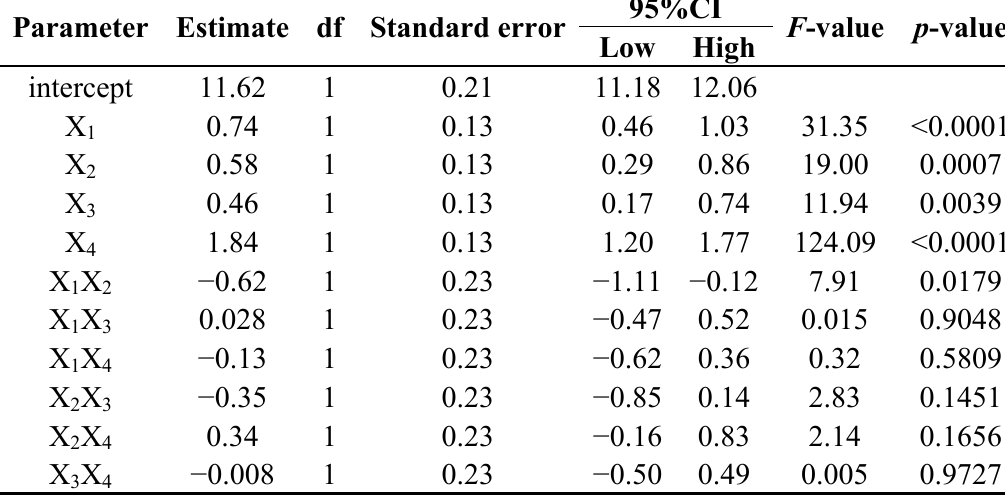
Table 2. Test result of significance for regression